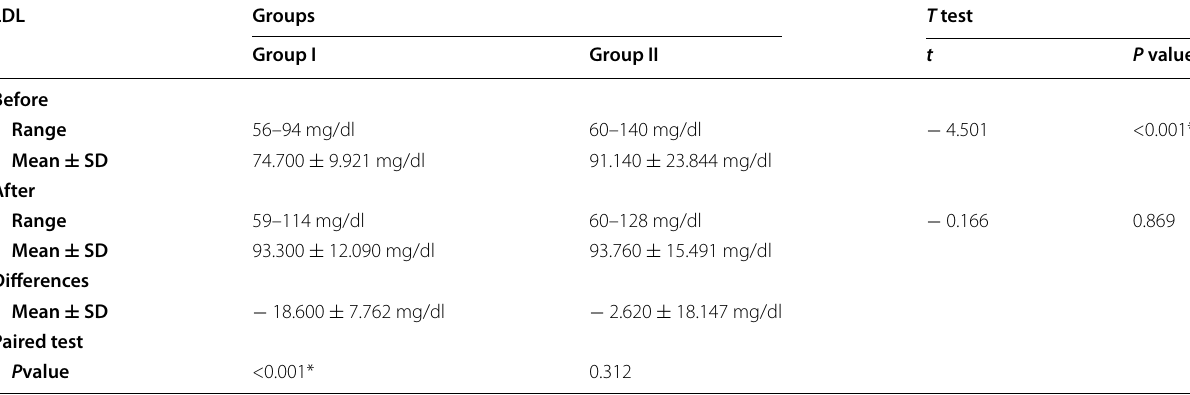
t Student’s t test, p p value for comparing between the two